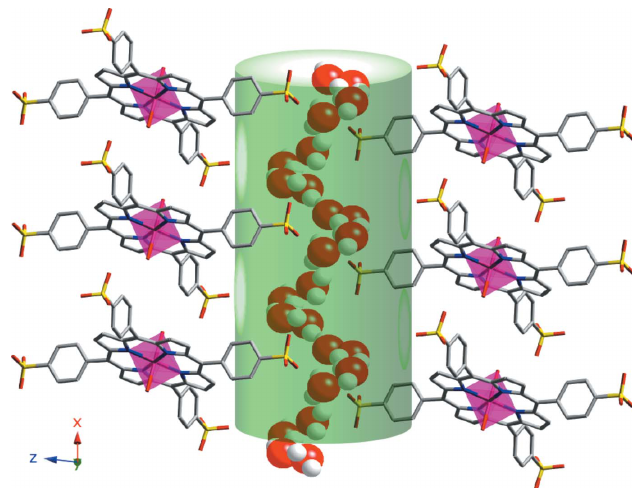
Fig. 1. The voids generated between metalloporphyrinic monomers are occupied by [H(bipy)] + cations and crystallized bipyridine molecules and, as shown in Fig. S3, those bipyridine molecules were pairwise hydrogen-bonded [N5—H1N (cid:2) (cid:2) (cid:2) N4; 2.741 7 A˚ and 171 9 (cid:5) ] and parallel-stacked, giving rise to robust (cid:10) – (cid:10) interactions (centroid-to-centroid distances are 3.468 and 3.746 A˚ ) (Soltanzadeh & Morsali, 2009). Addi-